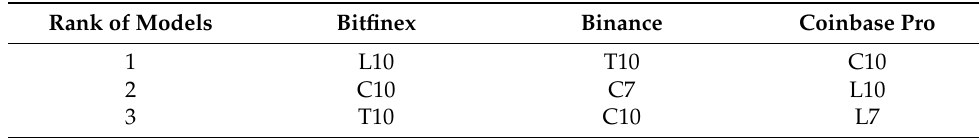
Table 16 suggests that L10, C10, and T10 were the top three models in the Bitfinex from Table 17. Table 18 indicates that C10, L10, and L7 are the best predictor models for the Coinbase Pro dataset. The top three predictor models in each of the three datasets under study are represented in Table 19. Table 19. Top three predictor models in each dataset. Table 19. Top three predictor models in each dataset.